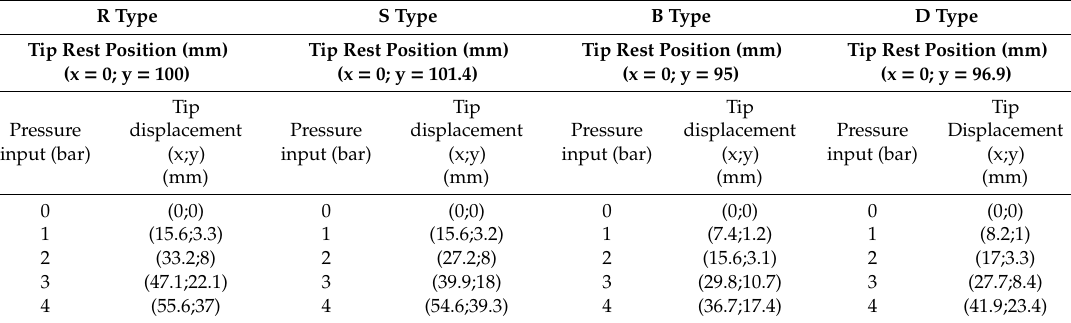
Figure 12. Bending angle vs. pressure for each MBP type. Table 5. Displacement from rest position in x–y space for each monolithic bending PneuNets (MBP) type.